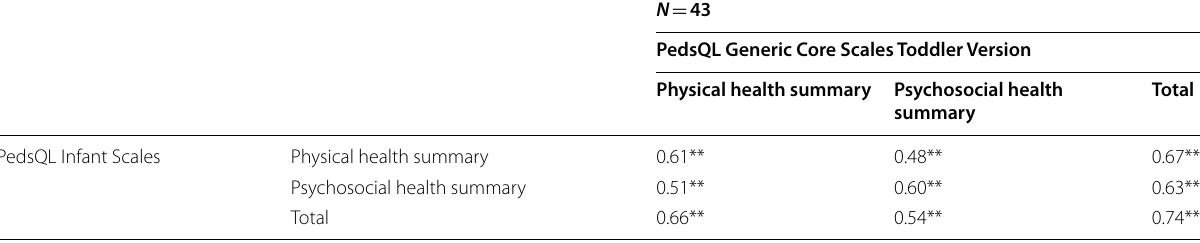
Table 7 Concurrent validity of the Japanese version of the PedsQL Infant Scales